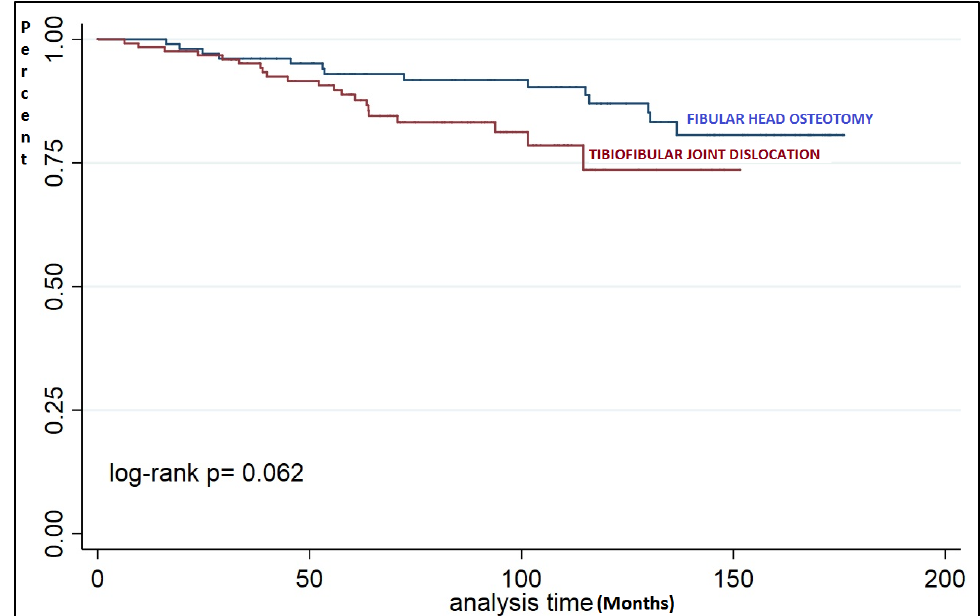
Figure 2. Survival analysis groups (log-rank test).